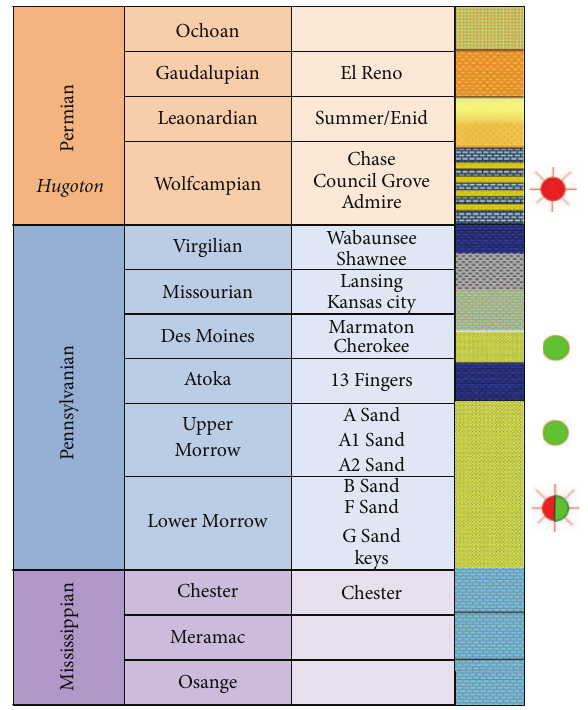
Figure 2: Stratigraphic column of Postle Field (courtesy Whiting Petroleum).